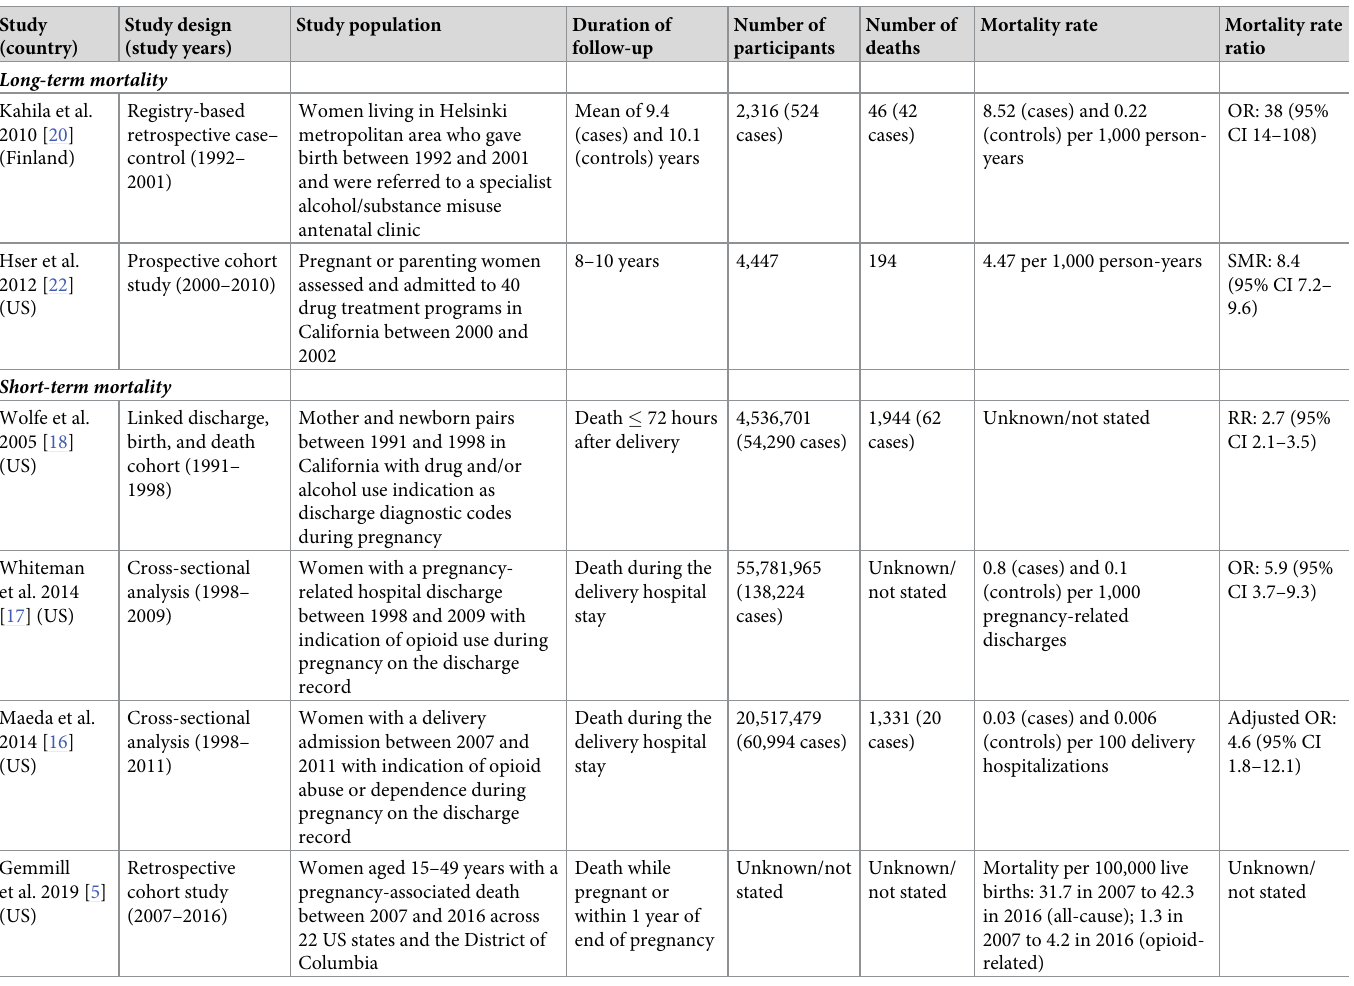
Table 1. Mortality rates from 6 population-based studies of women with substance misuse during